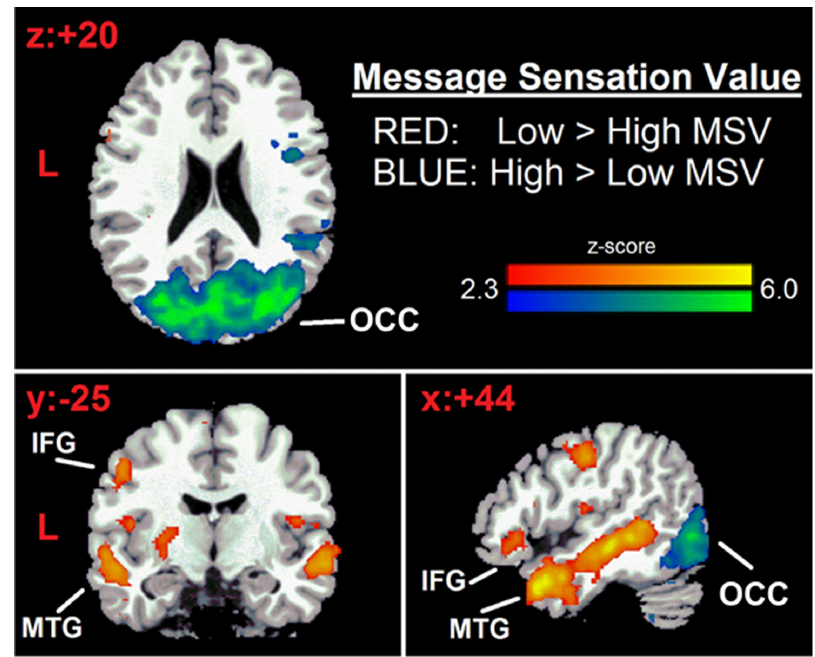
Figure 2. Brain response to safe-sex video messages. Middle temporal gyrus (MTG) and inferior frontal gyri (IFG) (red) have increased response for Low MSV . High MSV items. Occipital cortex (OCC) (blue) has increased response for High MSV . Low MSV ads. Statistical maps are displayed over the Montreal Neurological Institute (MNI) brain template and thresholded at Z=2.3, cluster-corrected for multiple comparisons at p , 0.05. Coordinates converted to Talairach space [45].